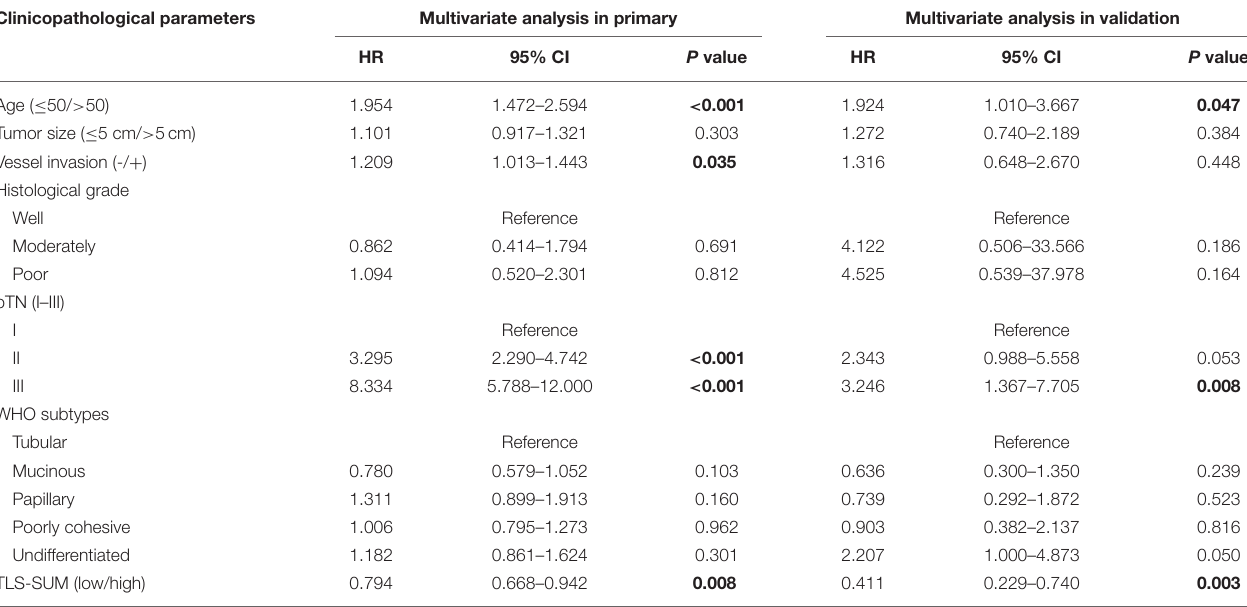
TABLE 2 | Univariate and multivariate Cox regression analyses of tertiary lymphoid structure (TLS)-SUM and clinicopathological parameters. Clinicopathological parameters